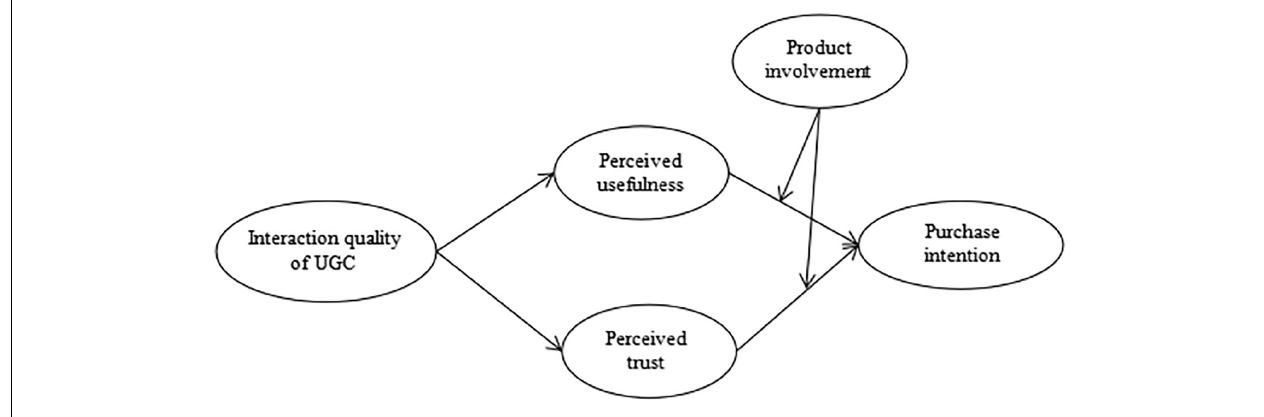
FIGURE 1 | Conceptual model.